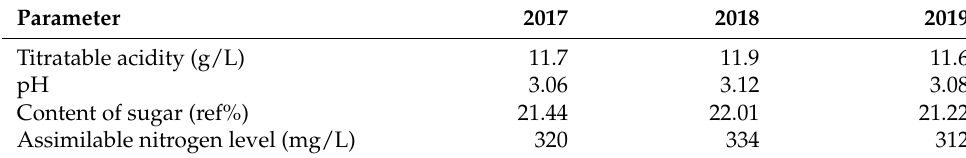
Table 1. Baseline data for the musts used for fermentation in the three vintages. Parameter Titratable acidity (g/L) pH Content of sugar (ref%) Assimilable nitrogen level